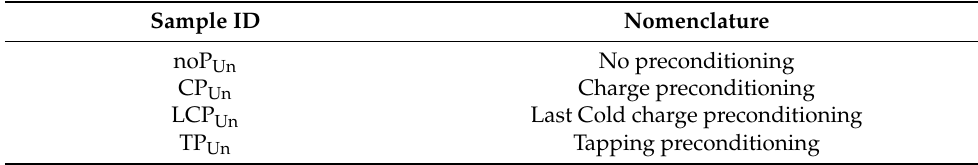
Table 3. Chemical composition (wt.%) of the samples.